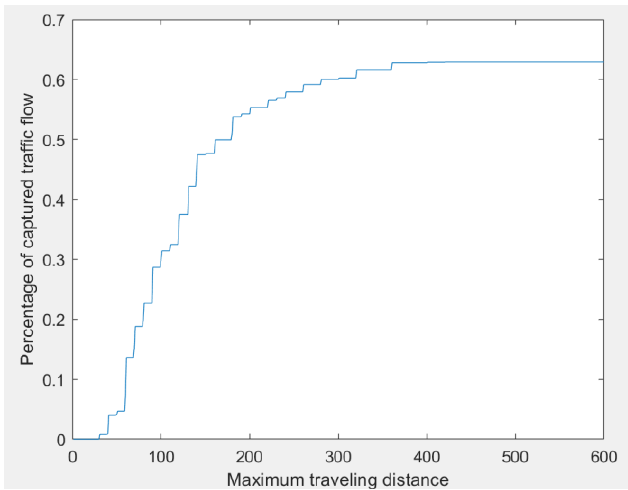
Figure 12. Percentage of the captured traffic flow for different maximum traveling distances.